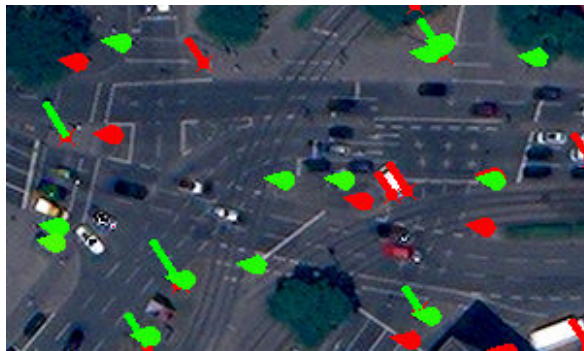
Figure 19. Detail 90 × 54 m 2 of fig. 18 showing correct detected poles and GCPs in green and misdetections in